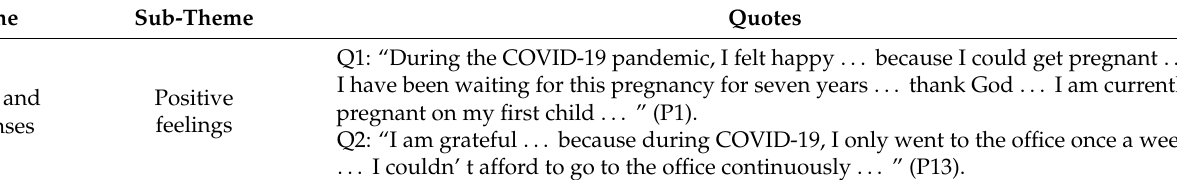
Table 2. Distribution of themes and sub-themes (n =